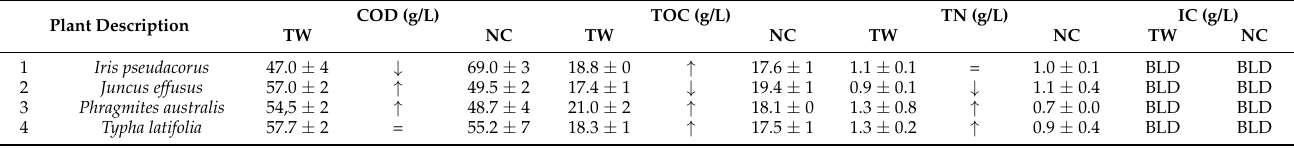
↑ indicates a positive effect of the TW in the concentration of the reported element. ↓ Indicates a negative effect of the TW in the concentration of the reported element. = Indicates a not significative effect of the TW in the concentration of the reported element. BLD: below limit of